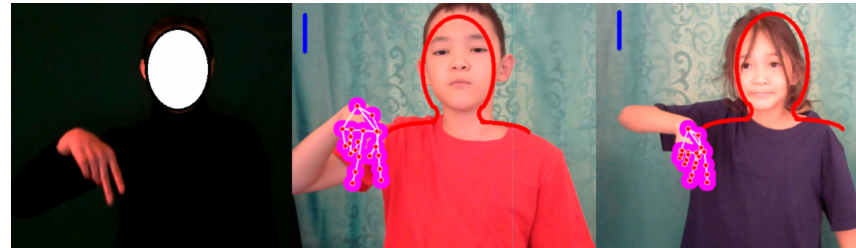
Figure 16. An example of a correctly working system.